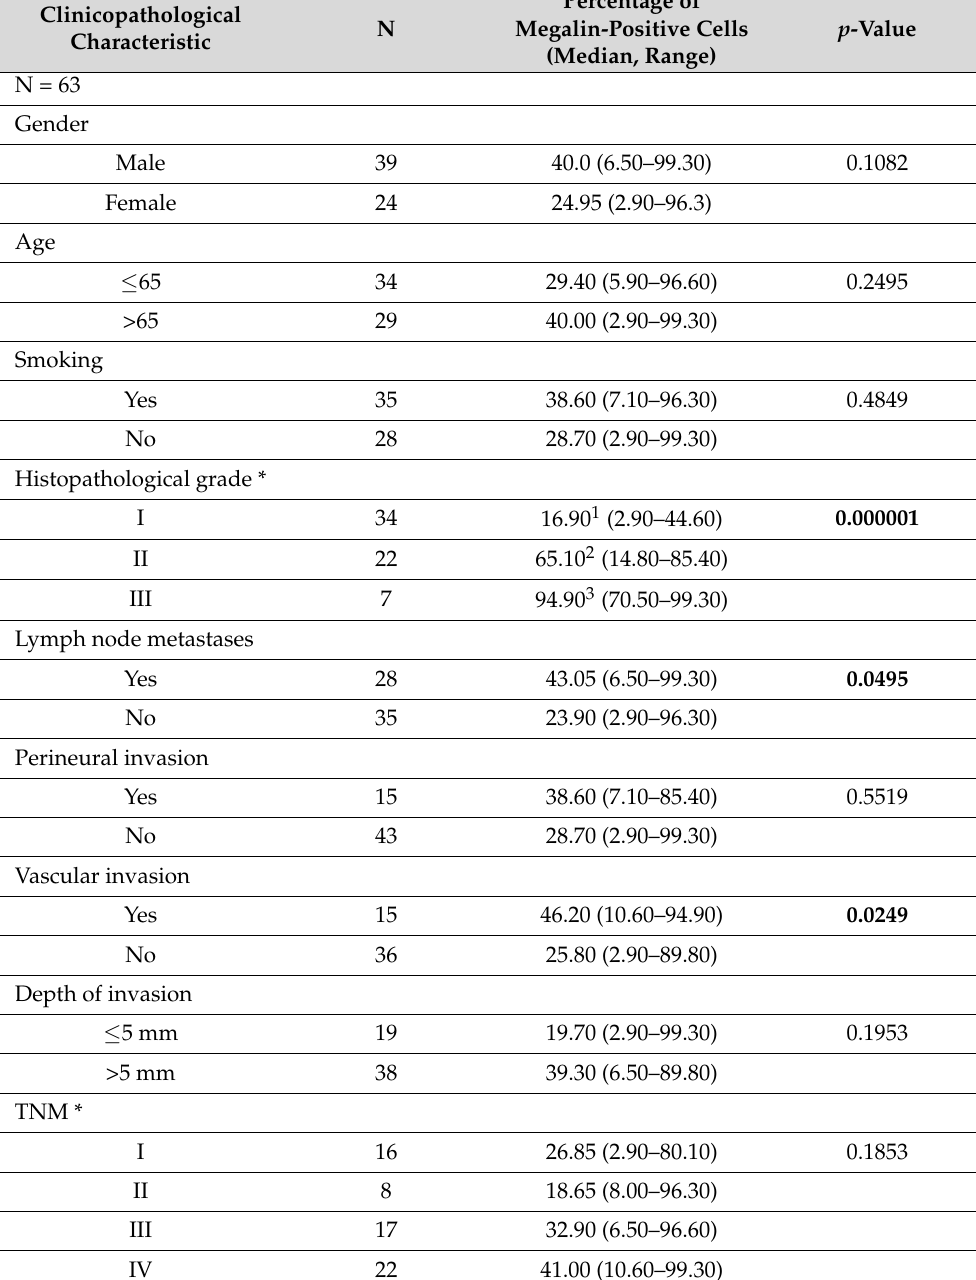
Table 1. Association between megalin expression in tumor cells and clinicopathological parameters in OSCC